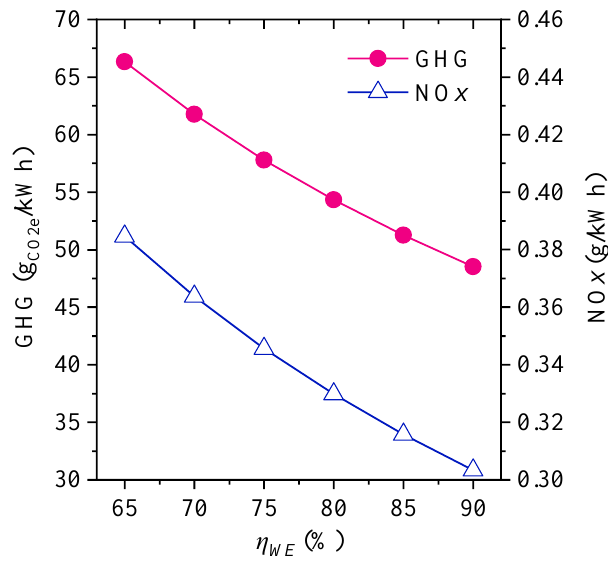
Figure 4. Variations in life cycle of GHG and NO x emissions with η WE .